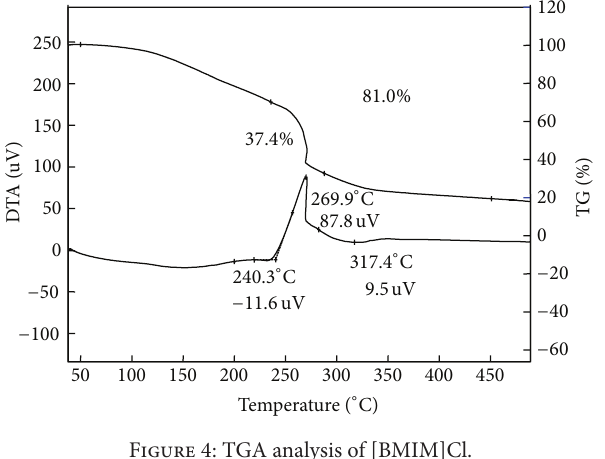
Figure 6: Effect of shear rate on viscosity of [BMIM]Cl.